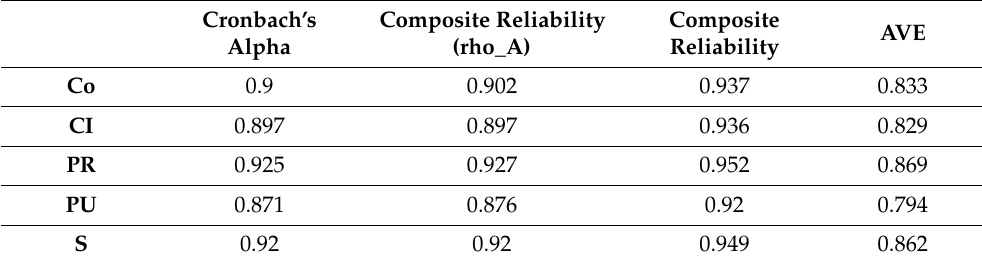
Table 4. Construct validity and reliability.